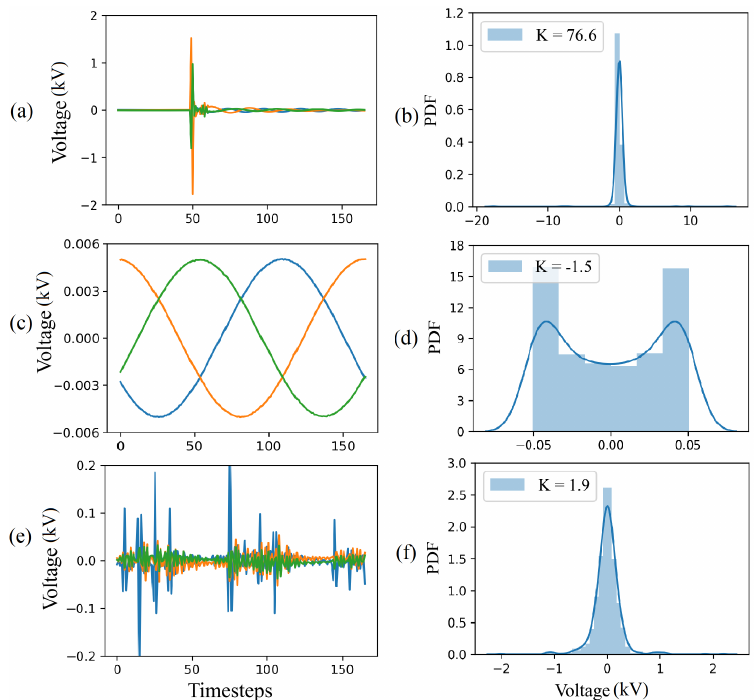
Figure 6. Kurtosis analysis: ( a ) differentiated voltage signal corresponding to a capacitor switching disturbance, ( b ) PDF of the voltage signal corresponding to a capacitor switching disturbance ( c ) dif- ferentiated normal steady-state voltage, ( d ) PDF of the normal steady-state voltage, ( e ) differentiated HIF voltage, and ( f ) PDF of the HIF